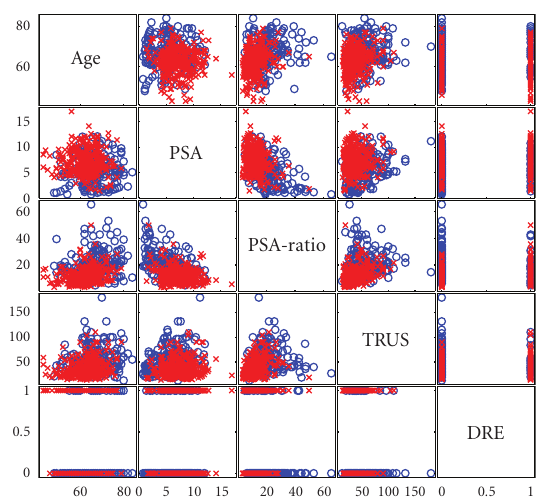
Figure 1: A scatterplot matrix of the data. Each box shows a pair of variables and the cases are color-coded, a red cross marks PCa, and a blue circle non-PCa. The DRE is a binary variable (suspicious or